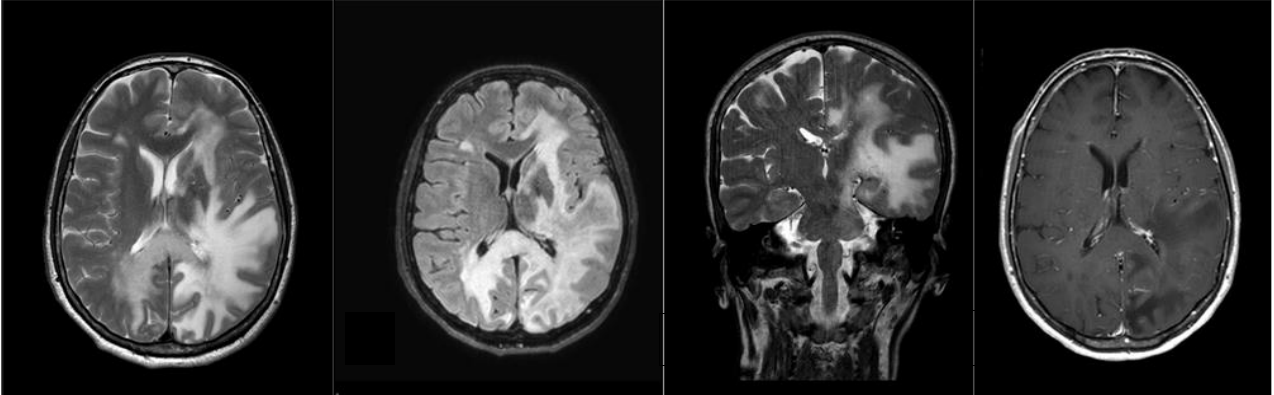
Figure 2. Progression of the area of altered signal intensity that extends to the left frontal lobe and passes the midline posteriorly through the corpus callosum into the right parietal and occipital lobe. FLAIR image showed the front of the infectious inflammatory pathological process, in the deep temporal region. There are no areas of pathological enhancement.